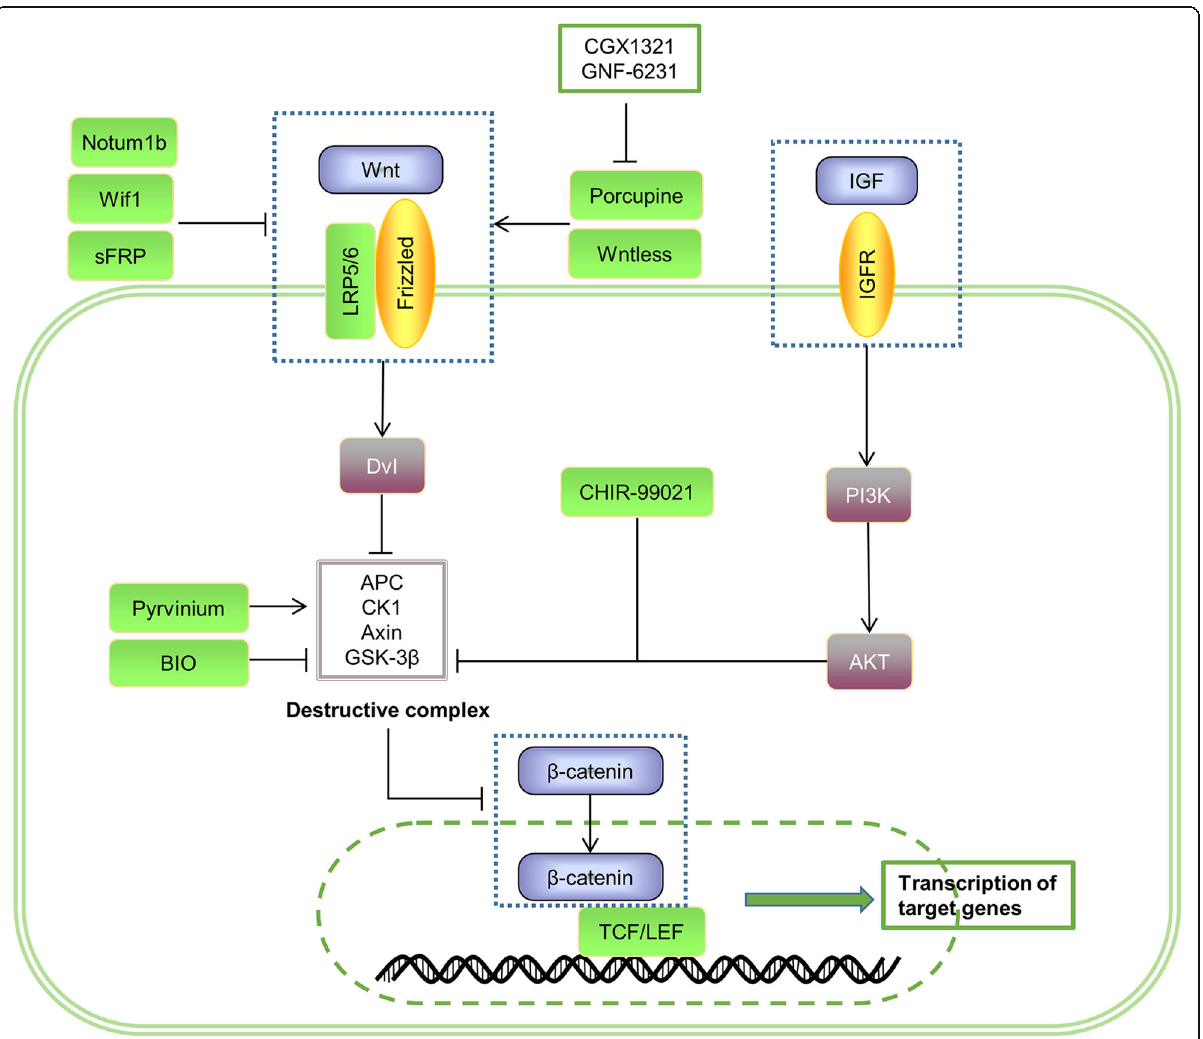
Fig. 3 The classical Wnt/ β -catenin signaling pathway in cardiac regeneration. After binding of Wnt ligands to their membrane receptors Frizzled and LRP5/6, Dvl inhibits the degradation of the disruption complex and stabilizes β -catenin in the cytoplasm. The increased β -catenin in the nucleus binds to TCF/LEF and regulates the transcription of target genes. In addition, the activation of IGF signaling during this process promotes the stabilization of β -catenin by affecting PI3K/AKT to inhibit the expression of GSK-3